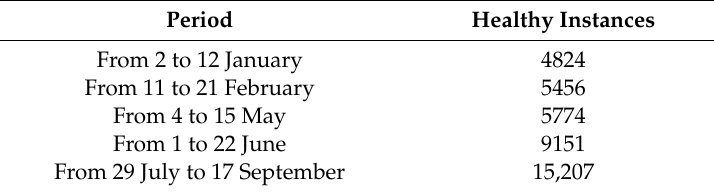
Figure 10. T 2 and Q for period E . Table 3. Explanation of healthy data for the period from A to